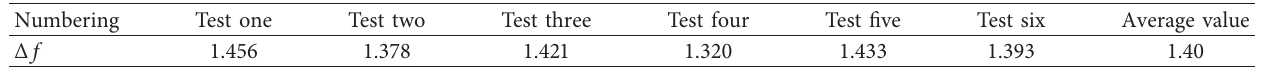
Table 10: Resonance frequency increment at unit corrosion